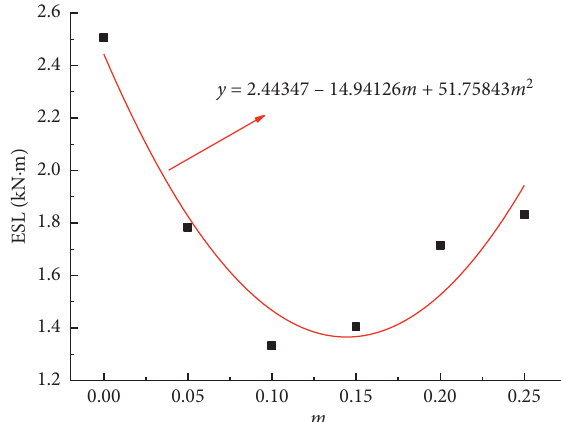
Figure 8: Relationship of the ESL and hole spacing index m